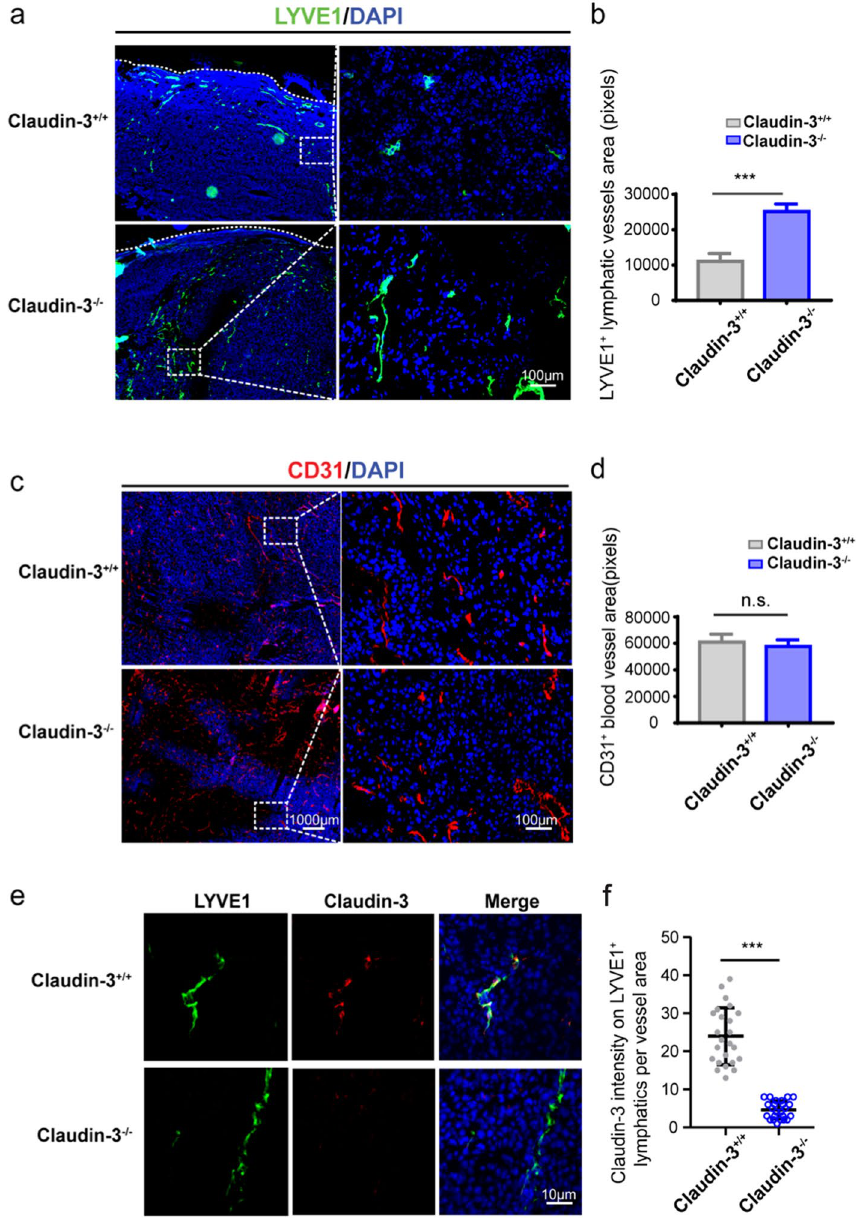
Figure 2. Loss of claudin-3 promoted lymphangiogenesis in primary tumor tissue. ( a ) Representative images of the lymphatic vessel marker LYVE-1 staining (green staining) in melanoma tissue of claudin-3 +/+ and claudin-3 −/− mice. Dashed lines indicate margin of tumor tissue. Left panel: 4X picture; scale bar, 1000 μm. Right panel: 20X picture; scale bar, 100 μm. ( b ) Statistical analysis of the lymphatic vessels under a high magnification (20X) fluorescence microscope. Values are shown as the mean ± SEM. (*** p < 0.001) (n = 20 fields per group) ( c ) Representative images of CD31 staining (red staining) in melanoma tissue of claudin-3 +/+ and claudin-3 −/− mice. Left panel: 4X picture; scale bar, 1000 μm. Right panel: 20X picture; scale bar, 100 μm. ( d ) Statistical analysis of the blood vessels under a high magnification (20X) fluorescence microscope . Values are shown as the mean ± SEM. (ns: no significance) (n = 20 fields per group) (e) Co-staining of tumor tissue from the claudin-3 +/+ and claudin-3 −/− mice with anti-LYVE-1 antibody (green staining) and anti-claudin-3 antibody (red staining). Scale bar, 10 μm. ( f ) Quantification of claudin-3 fluorescence intensity on LYVE-1 + lymphatics in e. (*** p < 0.001) (n = 24 vessels per